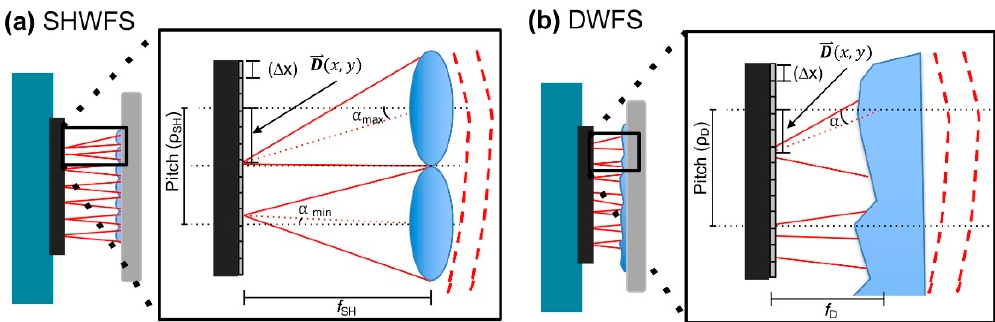
Figure 7. Differences between the dynamic range explored by SHWFS ( a ) and DWFS ( b ). The big squares represent the zoomed vision of the selected area. Figure reused from Ref. [24] under the terms of the OSA Open Access Publishing Agreement, © 2019 Optical Society of America.